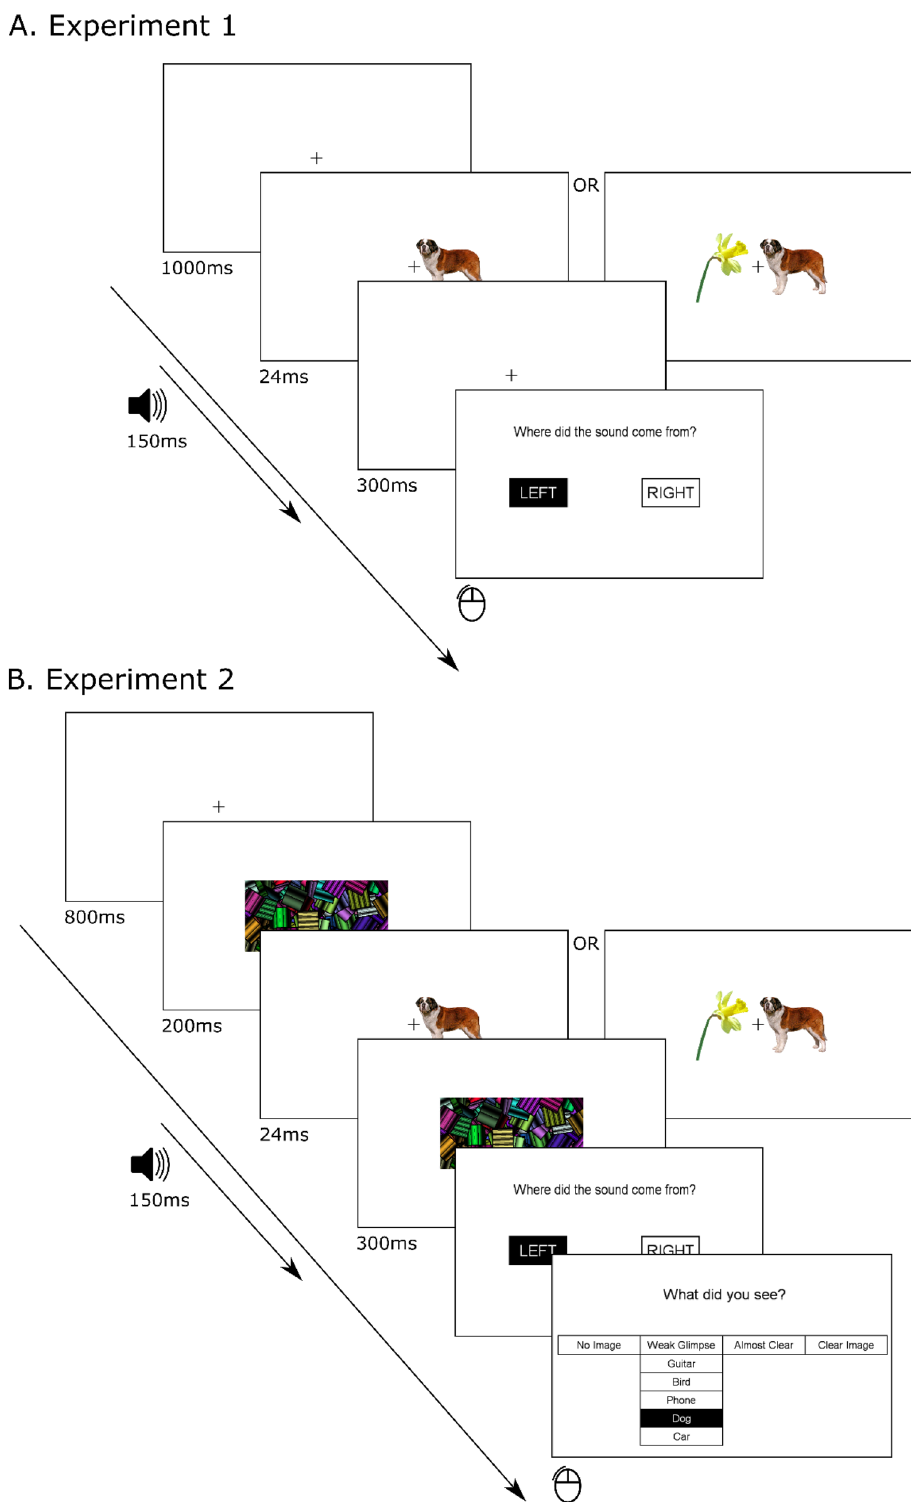
Figure 1. Example trials for unilateral and bilateral presentations. In unilateral visual presentations the picture of daffodil was not shown. ( A ) Experiment 1—without visual masking. ( B ) Experiment 2—with forward– backward